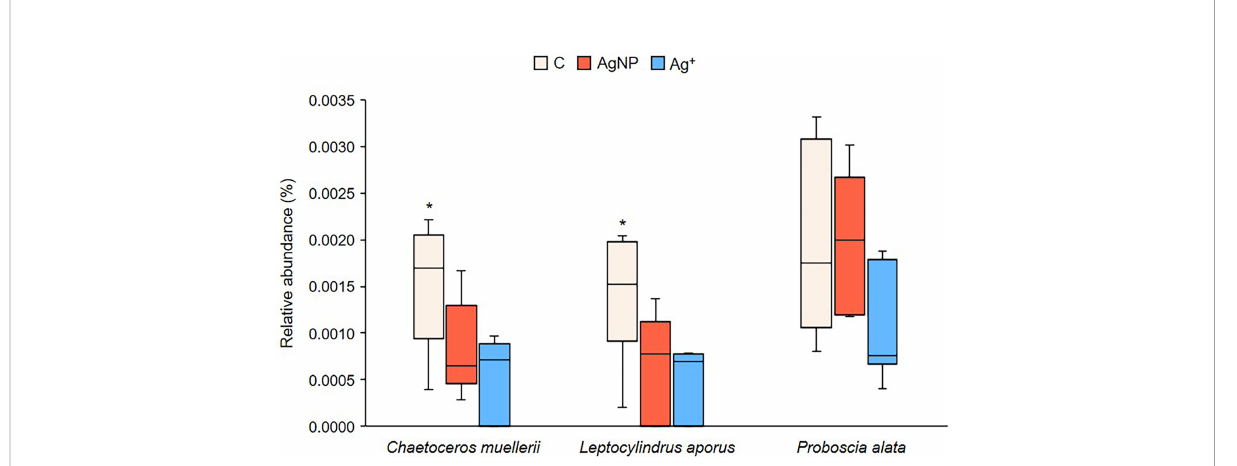
FIGURE 10 Differences in relative abundance of three diatom species. Asterisks above boxplots show which group signi fi cantly differs from the others, as indicated by Tukey multiple comparisons of means test (p<0.05).